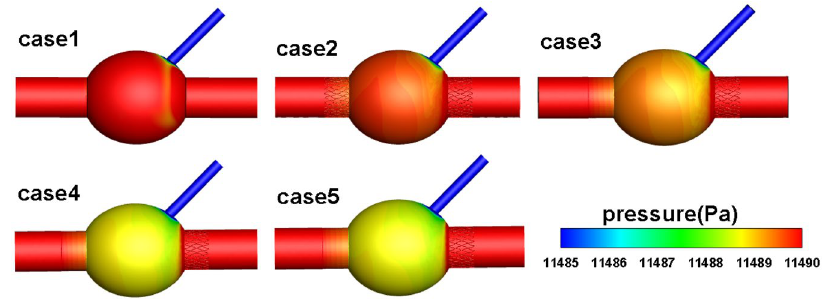
Figure 4. Pressure contour in the cases 1–5 models.